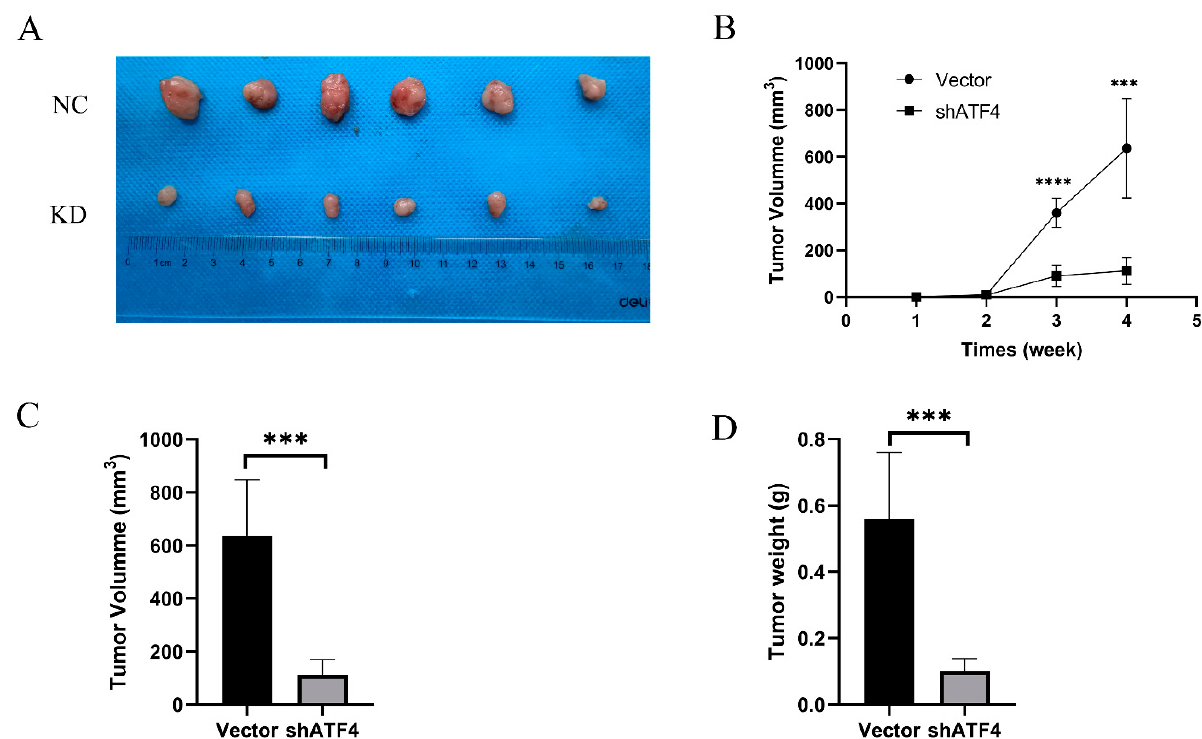
Figure 6. ATF4 knockdown downregulates the tumor formation of gastric cancer cells in a xenograft model. ( A ) Xenograft models in nude mice were generated using AGS cells transfected with Ctrl ( n = 6) or sh-ATF4 lentiviral ( n = 6). ( B ) The silencing of ATF4 greatly reduced the growth of the AGS tumor in mice when compared to the control group. ( C ) The average volume of the shATF4 group was significantly lower than that of the shCtrl group. *** p < 0.001, and **** p < 0.0001.